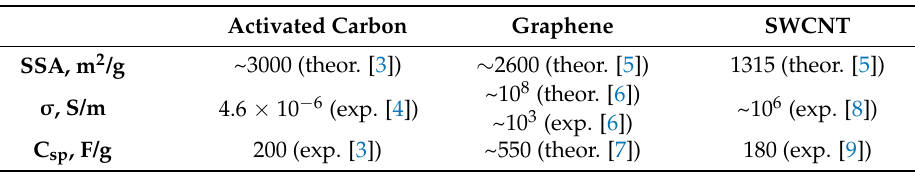
Table 1. Comparison of theoretical (theor.) and/or experimental (exp.) values of specific surface area (SSA), electrical conductivity ( σ ) and specific capacitance (C sp ) of different carbonaceous materials such as activated carbon, graphene and single-wall carbon nanotubes (SWCNT).